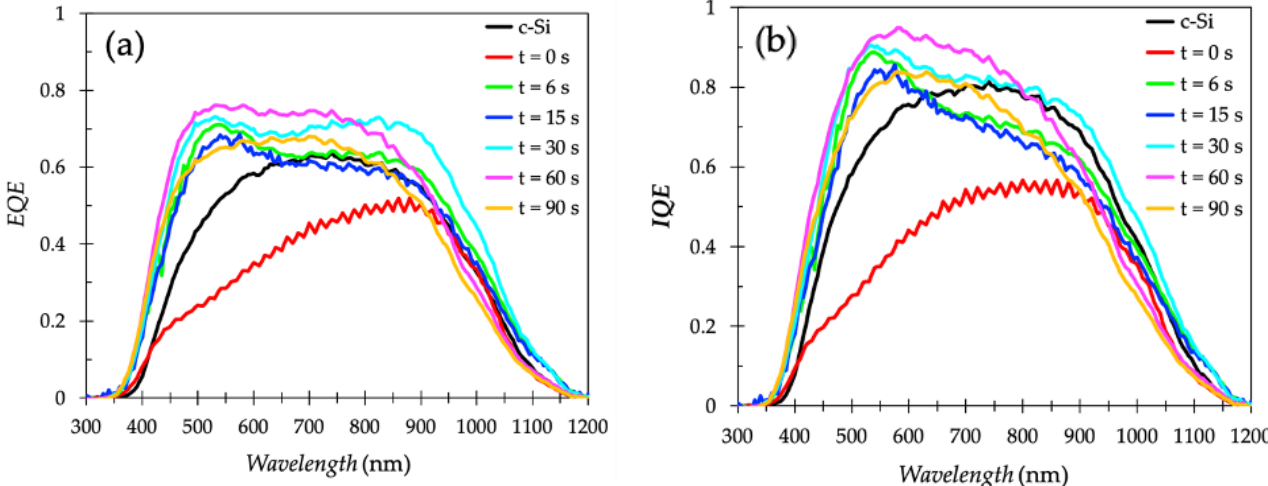
Figure 7. ( a ) EQE; ( b ) IQE of PS-2 cells for different t compared with as-fabricated PS-2 cell and reference c -Si